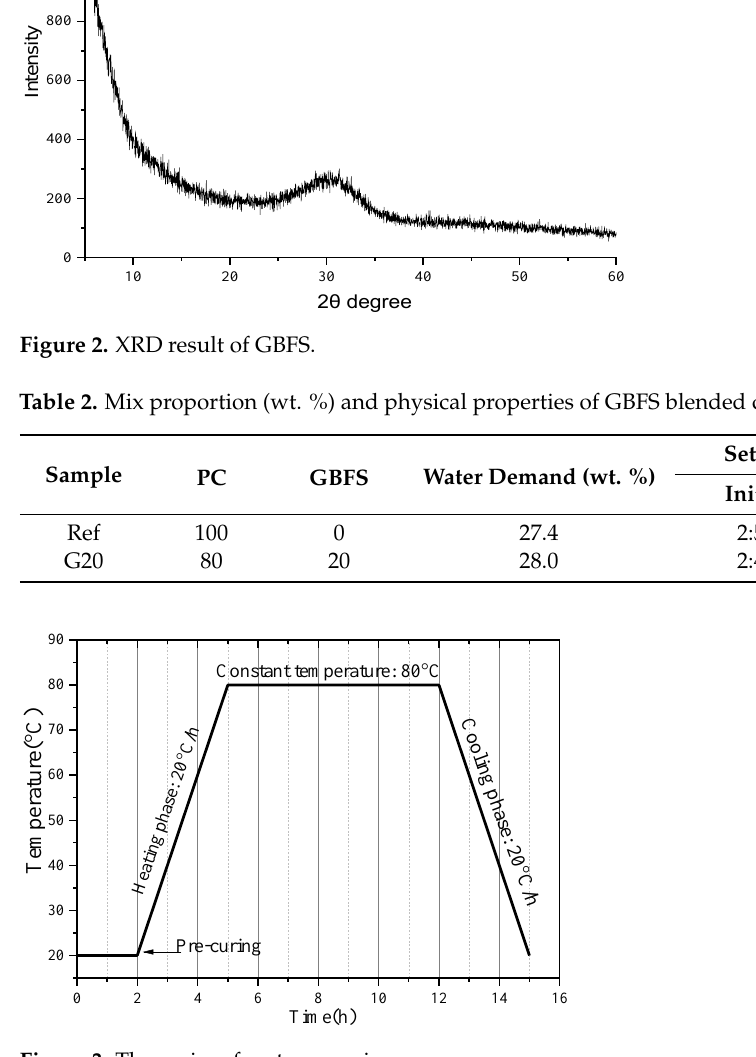
Figure 3. The regime for steam curing.